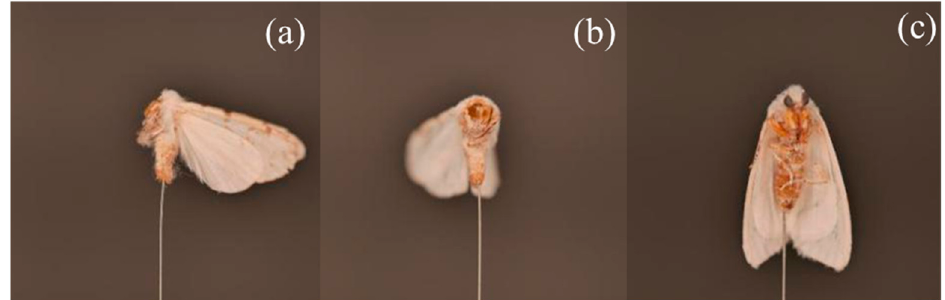
Figure 3. Images of the abdomen of H. cunea in different postures. ( a ) and ( b ) are abdomen of H. cunea with opened wings, ( c ) is the abdomen of H. cunea with closed wing.